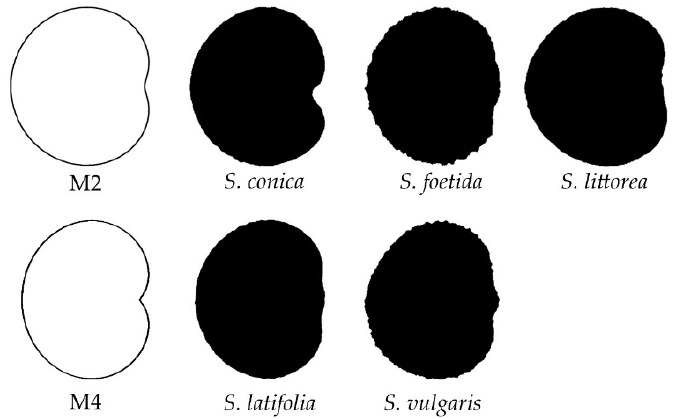
Figure 6. Models 2 and 4 based on the average silhouette and those Silene species with the best adjustment. The best fit for model 2 corresponds to S . conica , S . foetida , and S . littorea; for model 4, S . latifolia , and S . vulgaris .